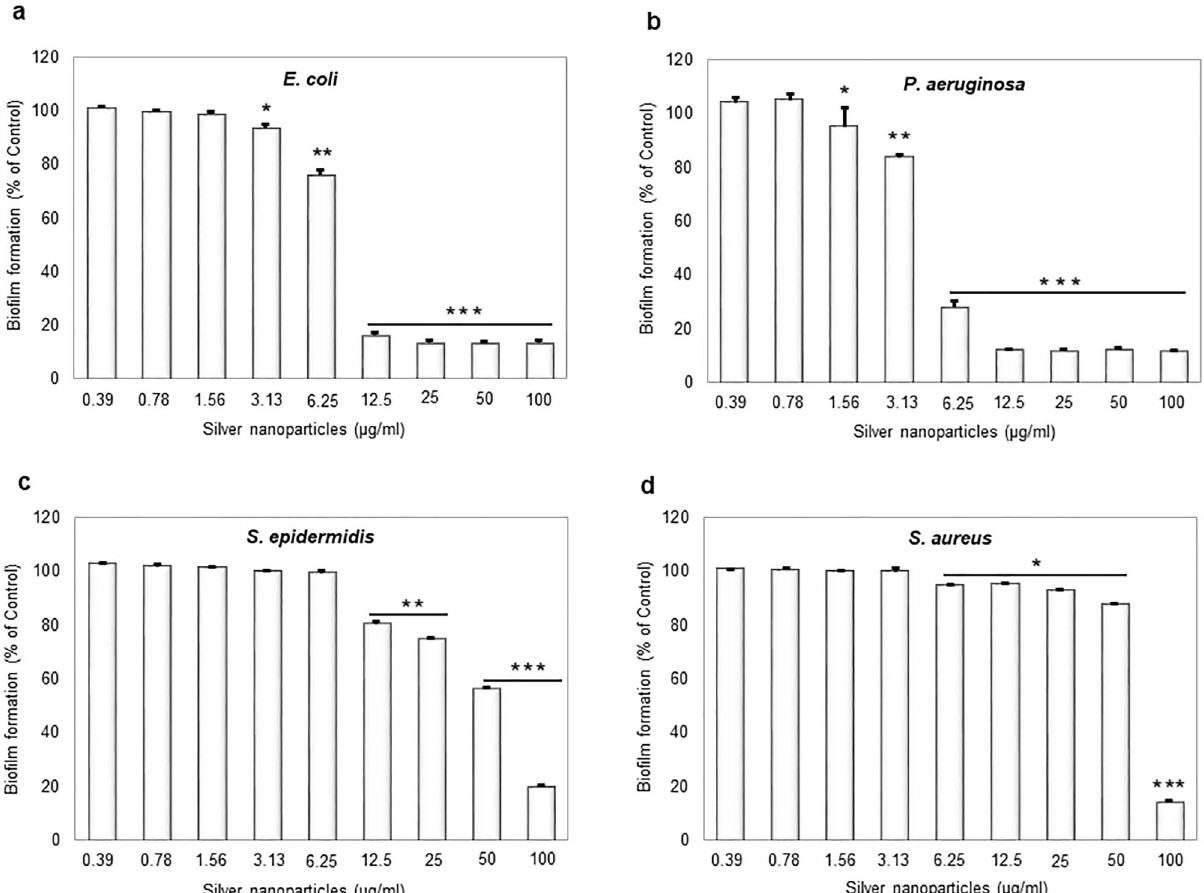
Figure 7. Effect of AgNPs on bacterial biofilm formation. ( a ) E. coli , ( b ) P. aeruginosa , ( c ) S. epidermidis , and ( d ) S. aureus . Data represent mean ± standard deviation error. *p < 0.05; **p < 0.005; ***p <